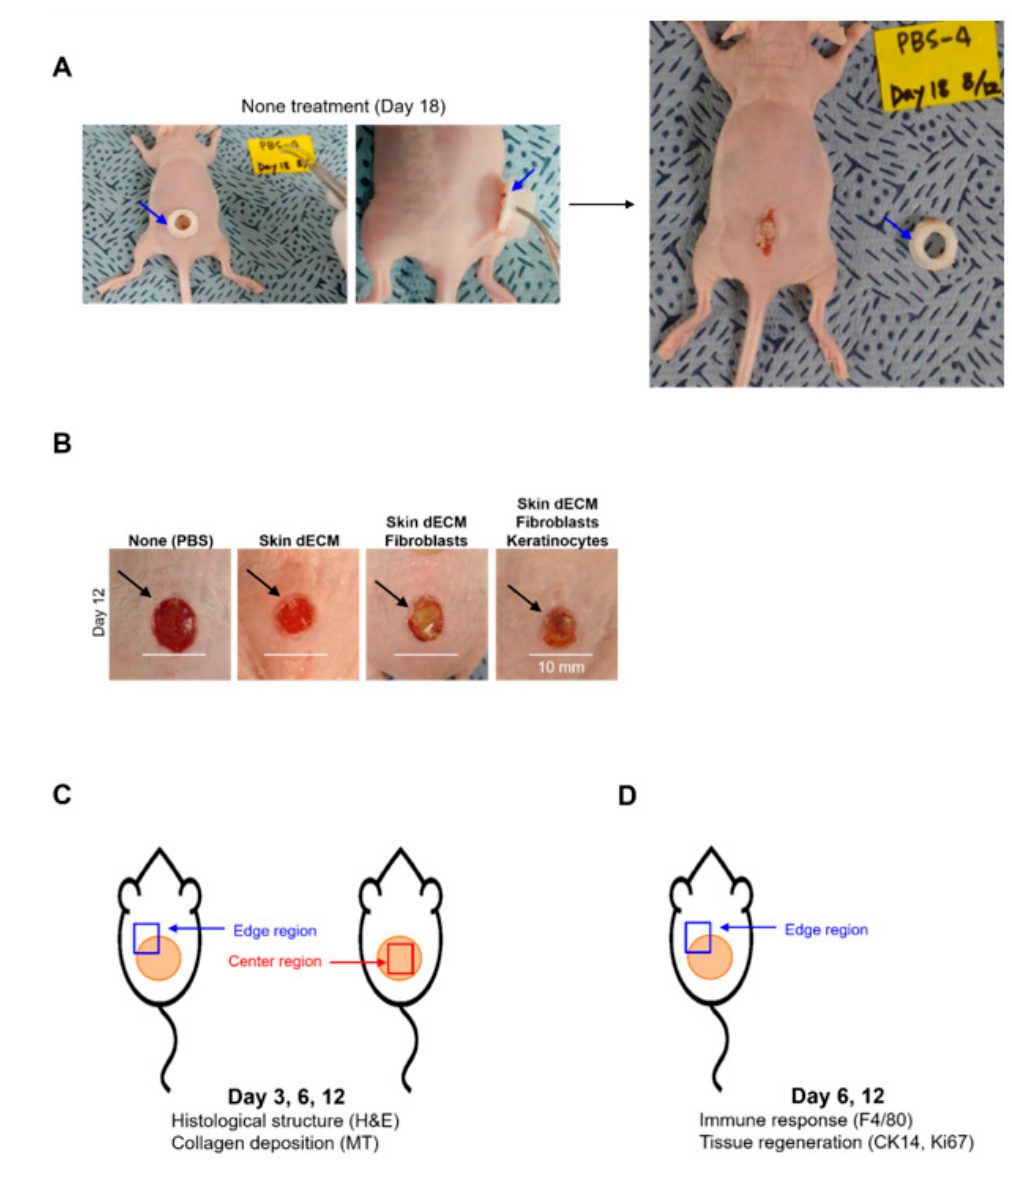
Figure 3. Evaluation of the usefulness of the 3D-printed chimney structures: ( A ) inspection of the maintenance of the 3D-printed chimney structures on day 18; ( B ) inhibition of wound contraction following the implantation of the chimney structures at 12 days; ( C , D ) analysis of the wound samples.